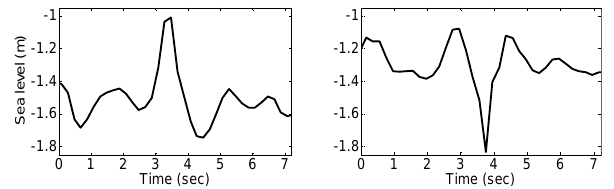
Figure 6. Enlargement of positive (left) and negative (right) freak wave traces presented in Figure 3.